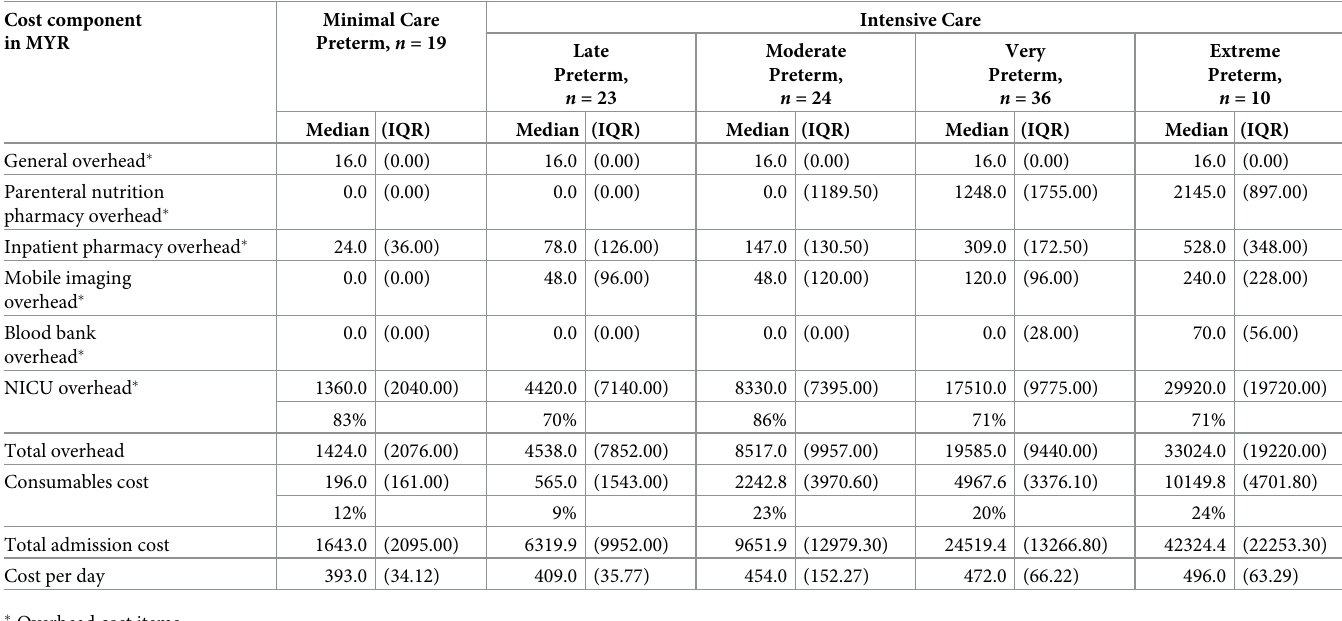
Table 3. Cost per preterm